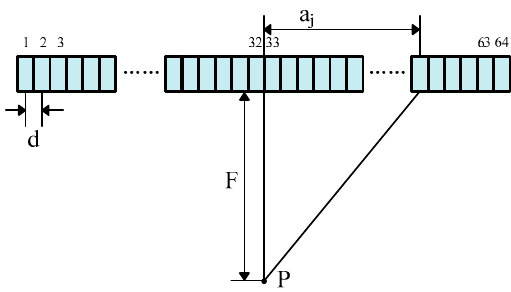
Figure 5. Calculation of the focusing delay time τ for the linear array transducer.